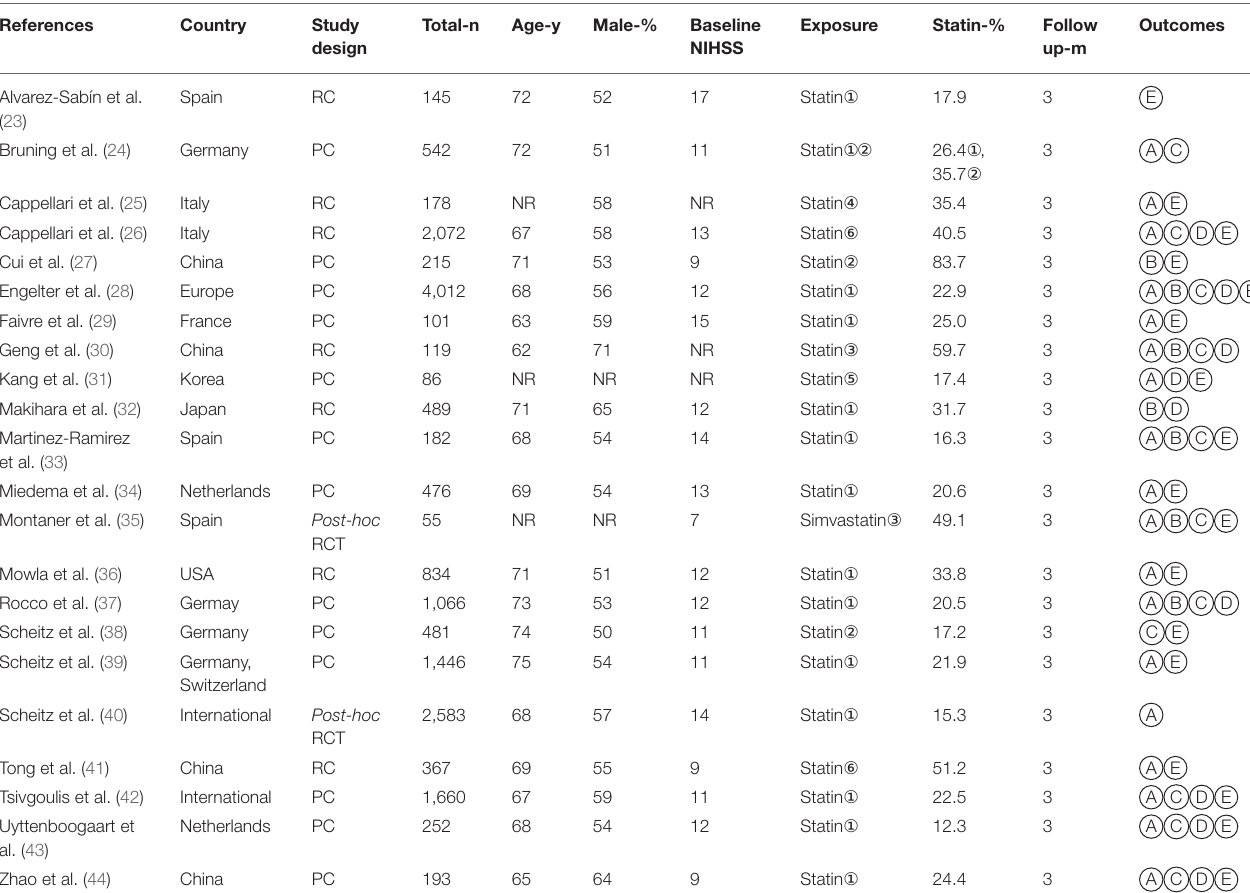
TABLE 1 | Baseline characteristics of included